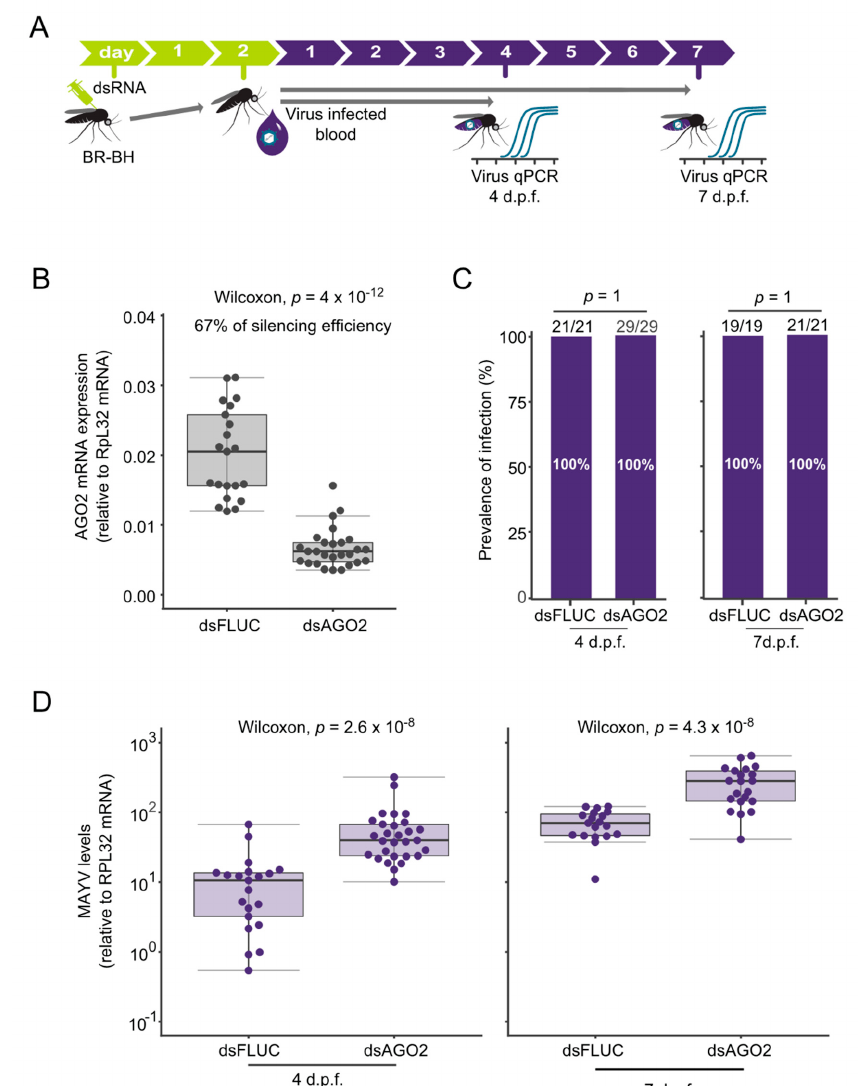
Figure 3. Knockdown of AGO2 increases MAYV replication in Aedes aegypti. ( A ) Scheme of the silencing process using dsRNA. BR-BH females were intrathoracically injected with dsAGO2 and dsFLUC (control group). 2 days post microinjection, mosquitoes were fed on a blood meal containing 10 9 p.f.u. mL − 1 of MAYV. Mosquitoes were collected at 4 and 7 d.p.f and tested individually by qPCR to detect viral RNA levels. ( B ) Mosquitoes collected at 4 d.p.f were also tested individually by qPCR for AGO2 mRNA expression for measuring the silencing efficiency. Each dot represents an individual whole mosquito. Statistical analyses were performed using the Mann-Whitney-Wilcoxon test, comparing the Ago2 expression levels. ( C ) Prevalence of infection. Total number of mosquitoes tested are indicated above each column. Statistical analyses were performed using the two-tailed Fisher’s exact test. ( D ) MAYV RNA levels at 4 and 7 d.p.f. Each dot represents an individual whole mosquito. Statistical analyses were performed using the Mann-Whitney-Wilcoxon test, comparing the MAYV titers of the infected mosquitoes.